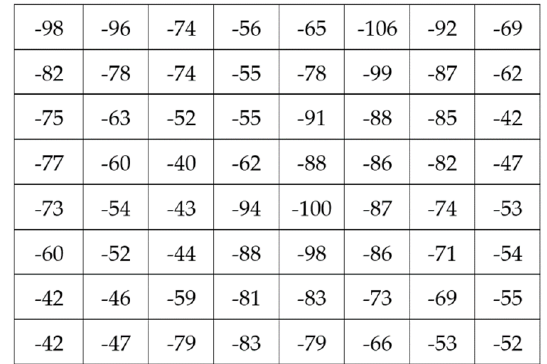
Figure 4. The luminance histogram for a block of 8 by 8 pixels.